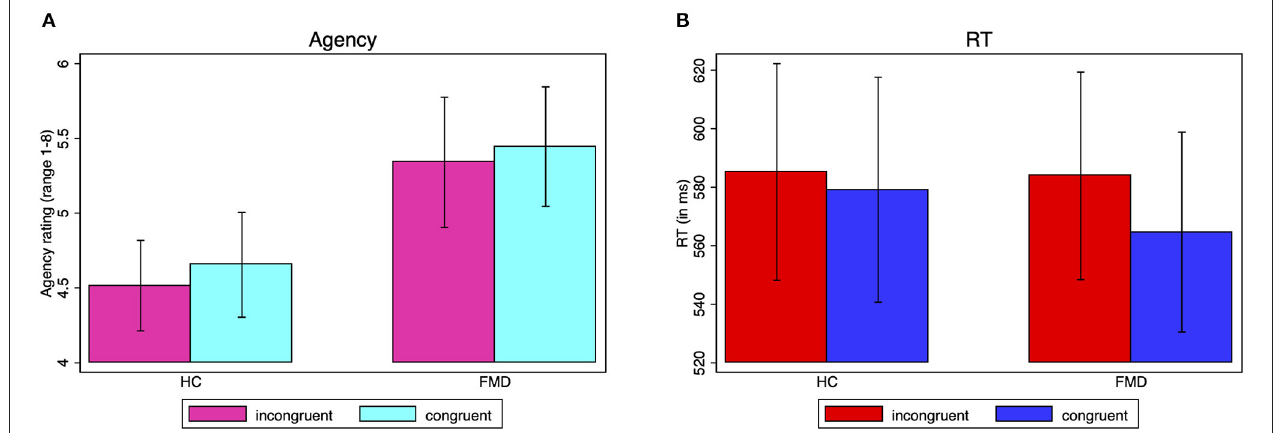
FIGURE 2 | Subliminal priming agency ratings and reaction times. Average agency ratings (A) and reaction times (B) by group for prime-response incongruent vs. congruent responses, irrespective of the type of choice (unidirectional or bidirectional imperative arrow). The agency rating ranges from 1 (absolutely no control) to 8 (complete control). The standard error of the mean is shown by the error bars.